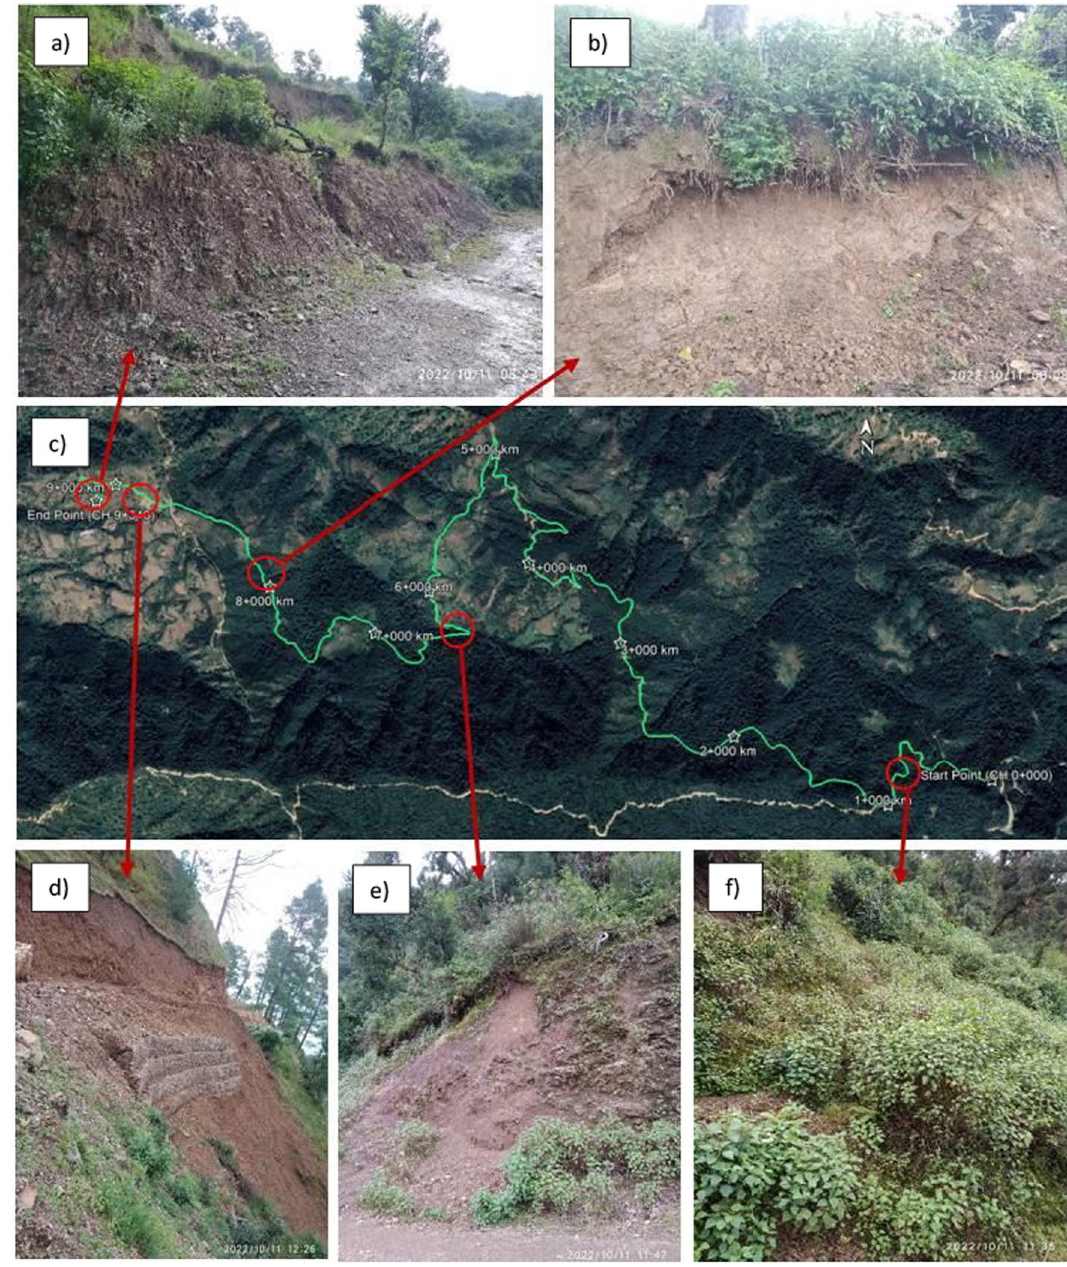
Fig. 9 Representative slope conditions of the Anarkholi-Bajkot-Khateda